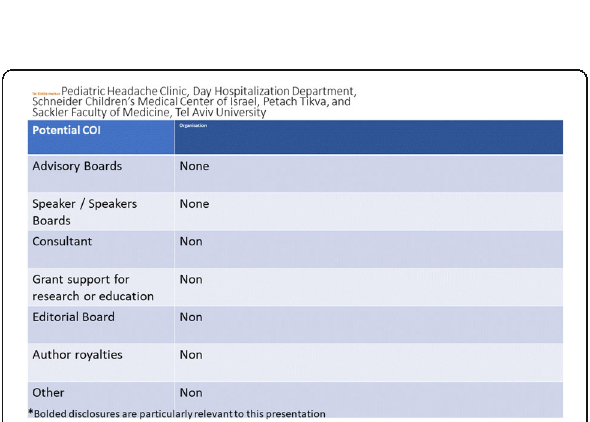
Fig. 2 (abstract P229). See text for description.